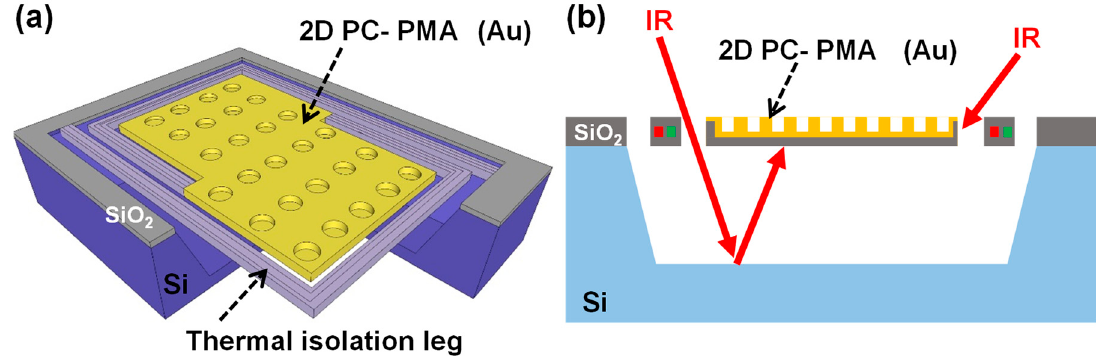
Figure 1. Schematic illustrations of ( a ) typical micro-electro-mechanical system (MEMS) based thermopile with 2D PC-PMA and ( b ) unwanted absorption at the backside and the sides of the 2D PC-PMA.